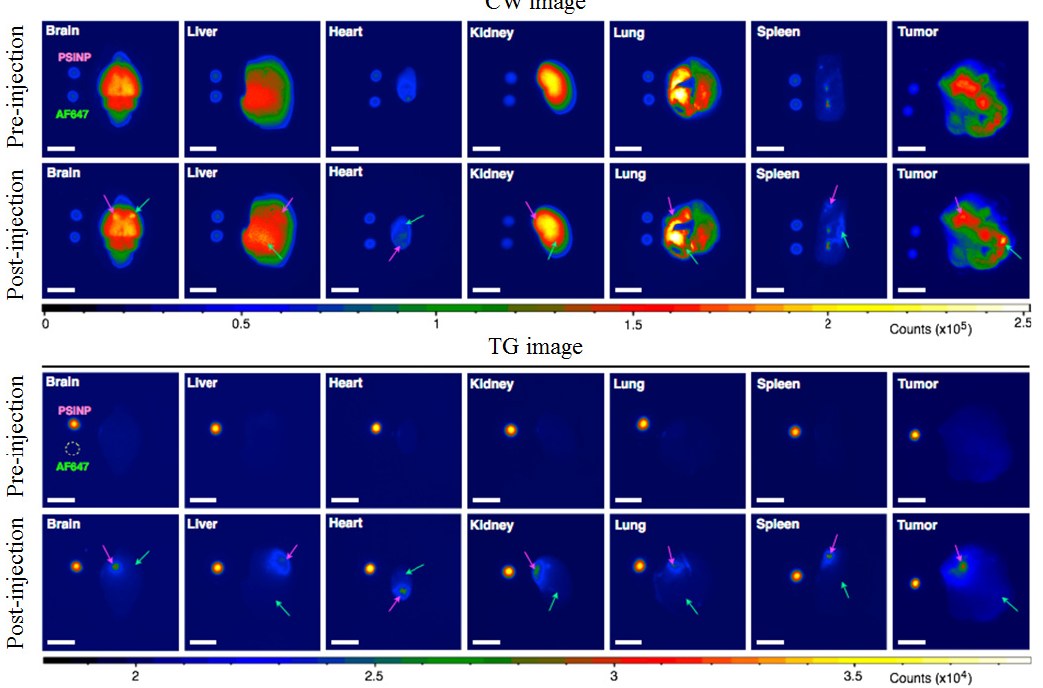
Fig. 12. Comparison of CW and TG images of ex vivo mouse tissues before and after localized injection of PSiNPs and AF647. The locations of injection of PSiNPs and AF647 are indicated by pink and green arrows, respectively. The same organs harvested from a 4T1 breast tumor-bearing mouse were imaged by CW and TG modes. PSiNPs can be clearly imaged by TGLI. Scale bar: 5 mm. Reprinted with permission from Ref. 35.